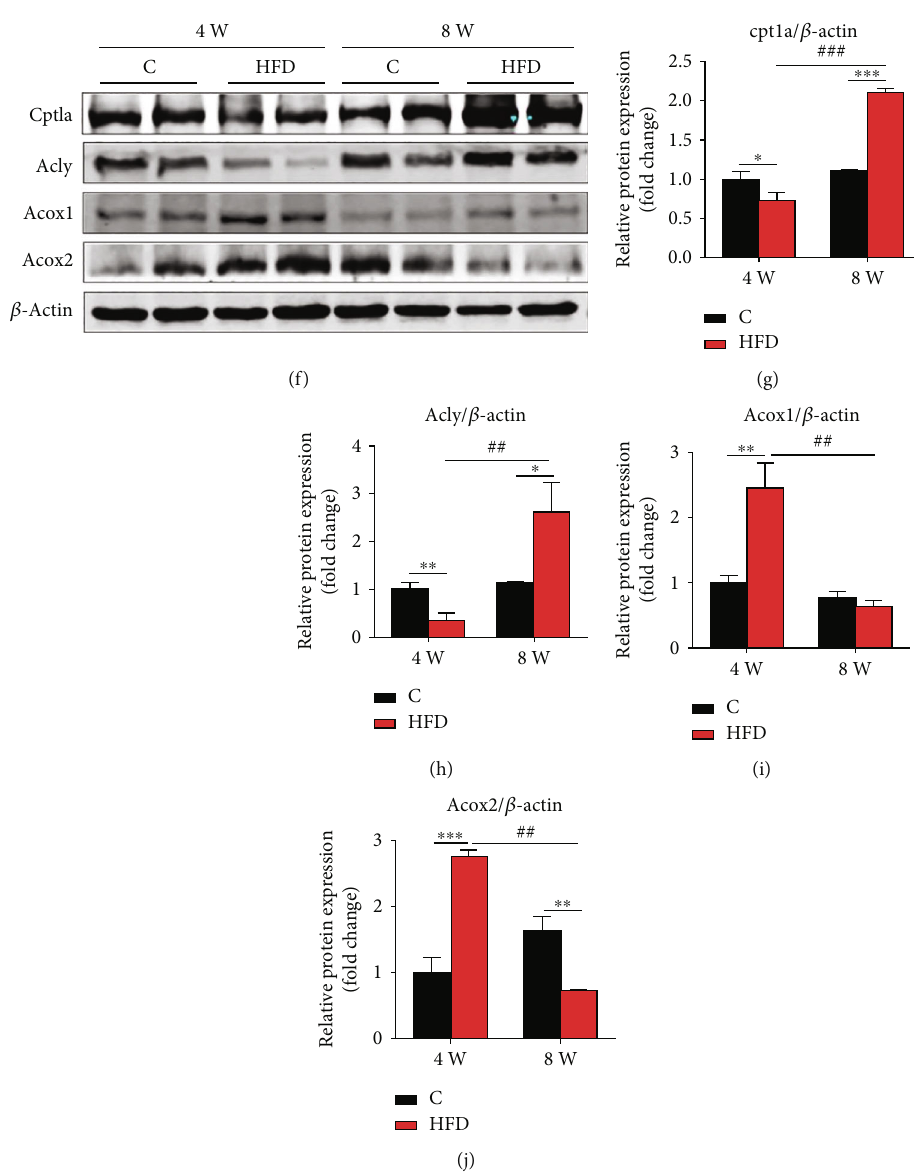
Figure 4: E ff ects of HFD on fatty acid synthesis, lipolysis, autophagy, and fatty acid β -oxidation in the liver of Nile tilapia after 4-week and 8-week feeding trials. (a – c) mRNA expression of genes related to FA synthesis (a), lipolysis (b), and autophagy (c) in the liver ( n = 9 ); (d, e) mRNA expression of genes related to lipid metabolism transcription factors (d) and mitochondrial FAO (e, n = 9 ); (f – j) relative expression of proteins related to mitochondrial (g) and peroxisomal (i, j) FAO and cytosolic acetyl-CoA synthesis (h) in the liver ( n = 4 ). Data are represented as means ± SD ; asterisks indicate the di ff erences between the C and HFD groups in the same feeding trial, ∗ P < 0 : 05 , ∗∗ P < 0 : 01 , ∗∗∗ P < 0 : 001 ; hash symbols indicate the di ff erences between 4-week and 8-week feeding trials of the same lipid level diet, # P < 0 : 05 , ## P < 0 : 01 , ### P < 0 : 001 ; C: control diet; HFD: high-fat diet. fasn : fatty acid synthase; acly : ATP citrate lyase; acc α : acetyl-CoA carboxylase alpha; atgl : adipose triglyceride lipase; hsl : hormone-sensitive lipase; mgl : monoacylglycerol lipase; atg5 : autophagy-related gene 5; atg7 : autophagy-related gene 7; srebp1 : sterol regulatory element binding protein 1; ppar α : peroxisome proliferator-activated receptor α ; cpt1a